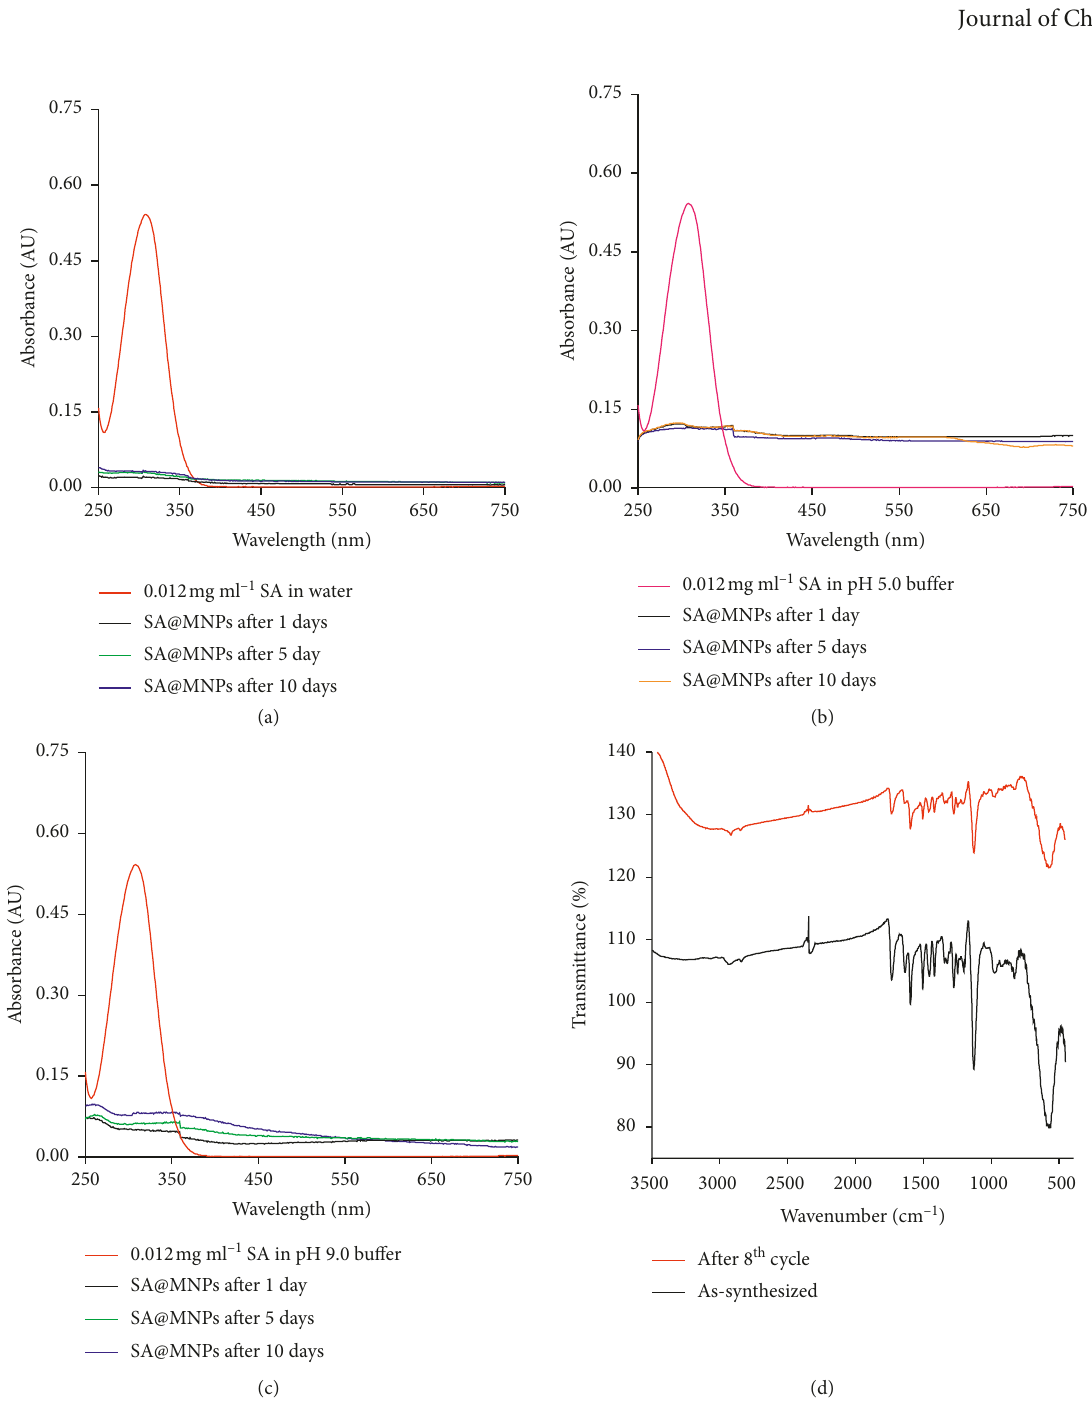
Figure 10: UV-Vis spectra of SA@MNPs dispersed in (a) water, (b) pH 5.0 buffer, and (c) pH 9.0 buffer for 1, 10, and 5 d (d) FT-IR spectra of the as-synthesized and recycled SA@MNPs